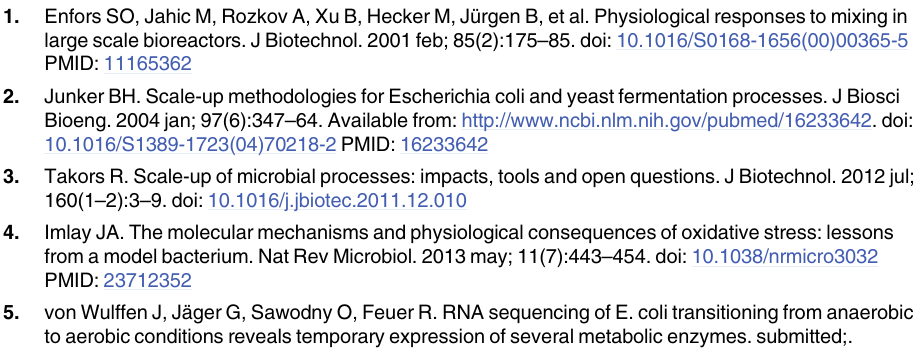
S1 Fig. Variation of global parameters. The translation constant is varied between 0.3 and 0.9 (columns); the threshold for regulation is varied between 0.1 and 0.9 (rows). (PDF) . The turnover number of CYTBO3_4pp is varied between 170.5 and S2 Fig. Variation of k cat 682 (columns); the turnover number of AKGDH is varied between 24.5 and 98 (rows).